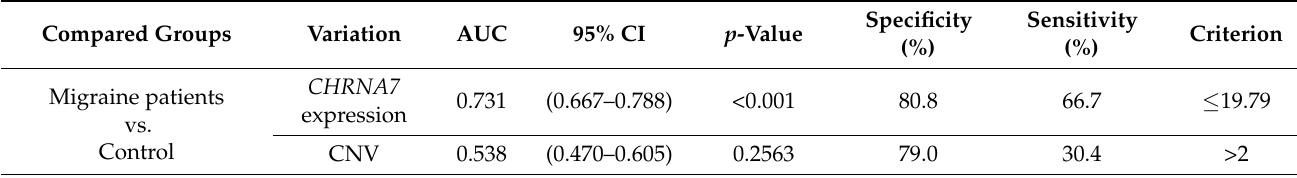
Table 8. The receiver operating characteristics curve analyses of the expression of CHRNA7 and CNV. Compared